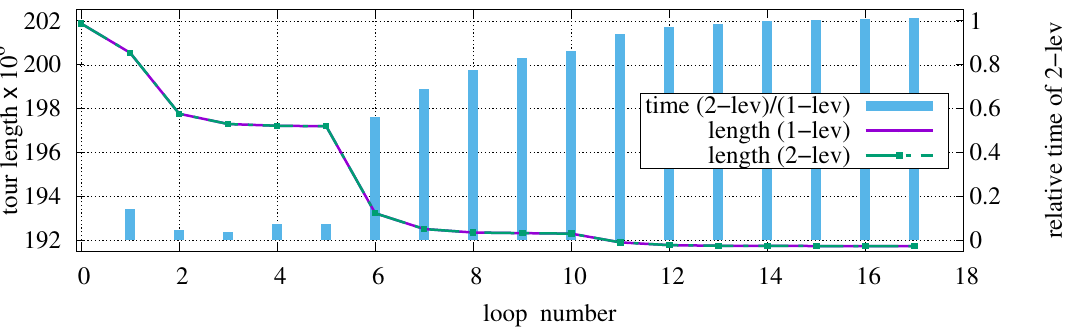
Figure 12. Tour length as a function of each loop when optimizing C316k.0 in dependence on the used data structure and relative time of two-level data structure compared to one-level structure.